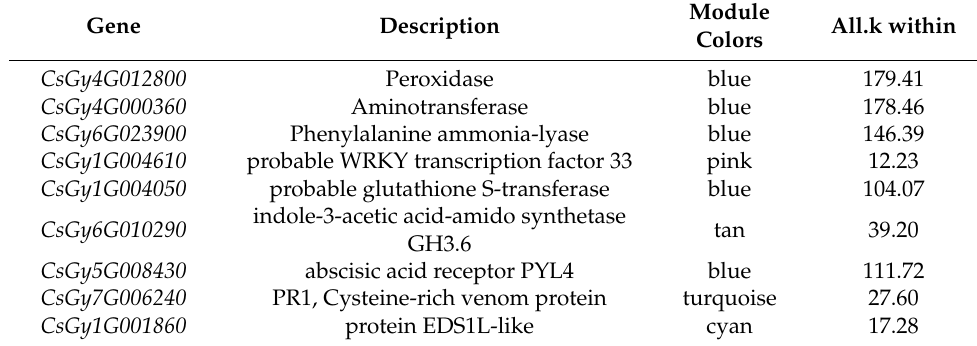
Table 1. Disease resistance-related hub genes revealed by